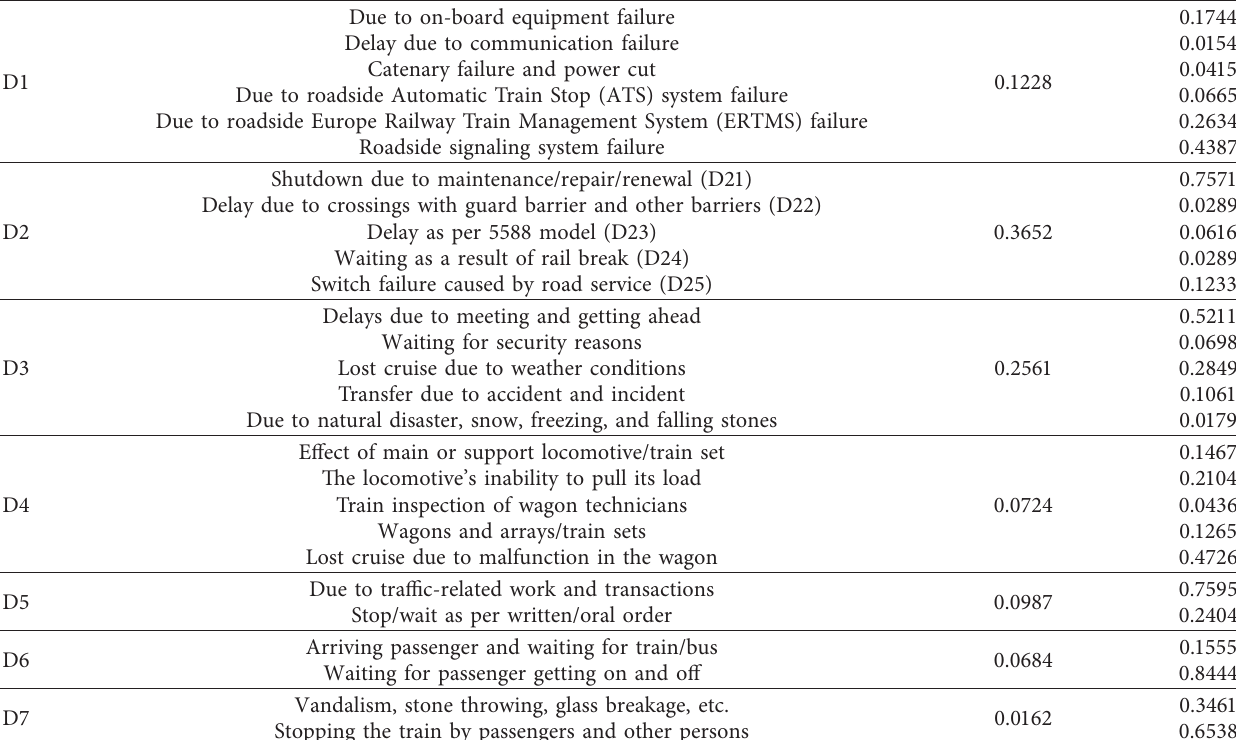
Table 13: Normalized criteria weights for each main criterion and